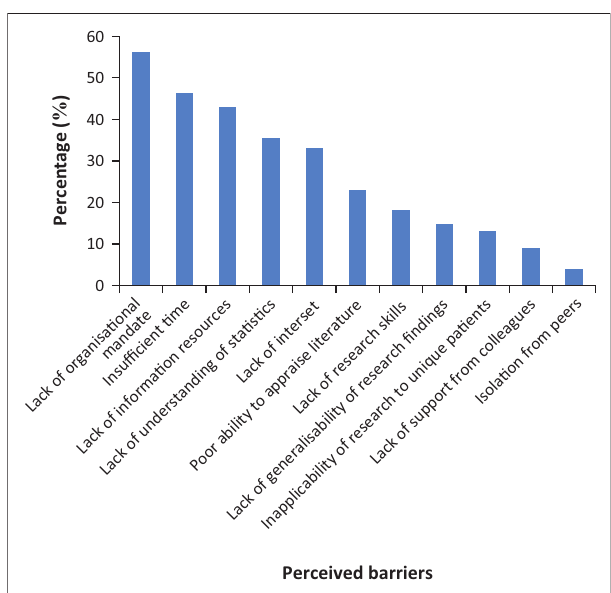
FIGURE 3: Perceived barriers to evidence-based physiotherapy